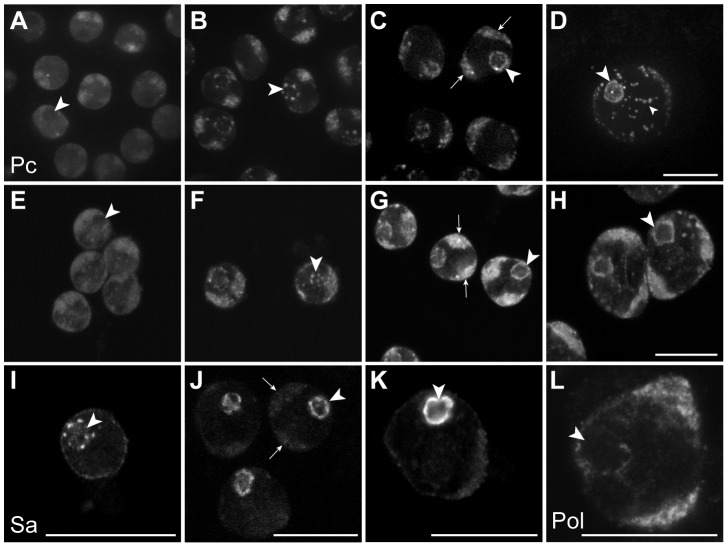
Sub-nuclear localisation of Pc, the tTAF Sa and elongating RNA polymerase II in primary spermatocytes.(A–H) Pc-GFP in live (A–D) and fixed immunolabelled (E–H) primary spermatocytes showing representative z sections of very early (A,E), early (B,F), mid (C,G) and mature (D,H) spermatocytes. (I–K) Sa-GFP in fixed immunolabelled primary spermatocytes showing representative z sections of early (I), mid (J) and mature (K) spermatocytes; a similar localisation is seen in live primary spermatocytes (data not shown). (L) Elongating RNA polymerase II (phosphoserine 2) in a mature primary spermatocyte nucleus. Large arrowheads indicate nucleolus; arrows indicate autosomal chromatin masses. The nucleoplasmic puncta (small arrowhead) in D are associated with Y loops and are not present in XO testes (data not shown). Scale bars represent 16 µm; A–D and E–H are at the same magnification.